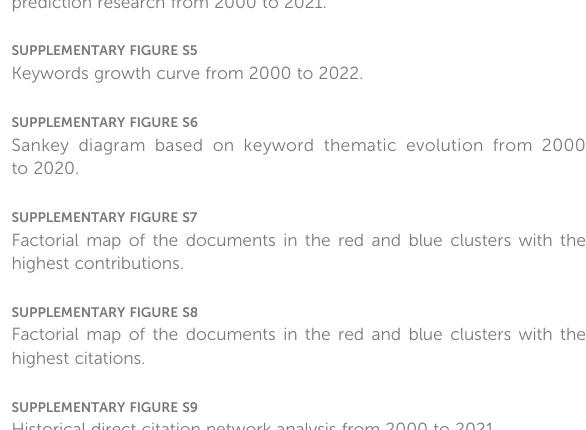
SUPPLEMENTARY FIGURE S1 Study Selection work fl ow. SUPPLEMENTARY FIGURE S2 Most relevant af fi liation in AI research for breast cancer detection and prognosis prediction. SUPPLEMENTARY FIGURE S3 Source clustering through Bradford ’ s Law. SUPPLEMENTARY FIGURE S4 Top fi fteen keywords in AI for breast cancer detection and survival prediction research from 2000 to 2021. SUPPLEMENTARY FIGURE S5 Keywords growth curve from 2000 to 2022. SUPPLEMENTARY FIGURE S6 Sankey diagram based on keyword thematic evolution from 2000 to 2020. SUPPLEMENTARY FIGURE S7 Factorial map of the documents in the red and blue clusters with the highest contributions. SUPPLEMENTARY FIGURE S8 Factorial map of the documents in the red and blue clusters with the highest citations. SUPPLEMENTARY FIGURE S9 Historical direct citation network analysis from 2000 to